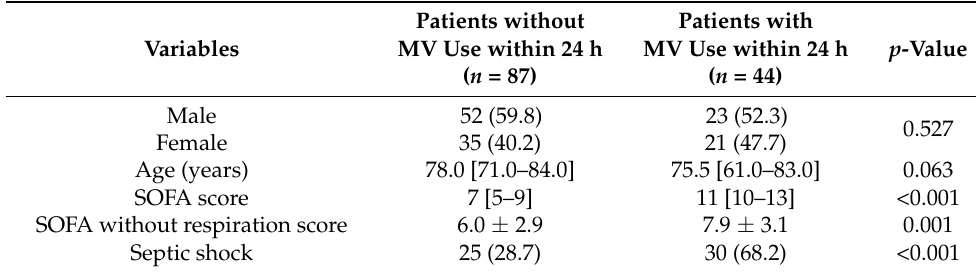
Table 1. Baseline and clinical characteristics of the study